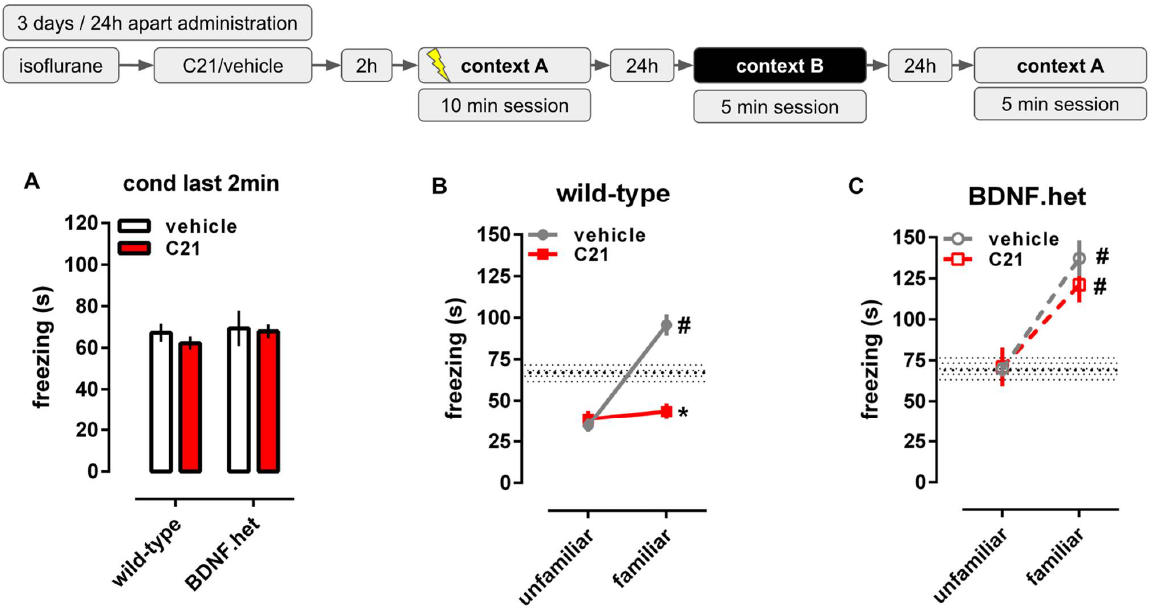
Figure 2. Effects of C21 in wild-type and BDNF haploinsufficient animals (BDNF.het) in contextual fear conditioning. ( A ) Administration of C21 (red bar, 0.3 mg/kg, intranasal) did not affect the freezing reaction at the end (last 2 min) of the conditioning session. ( B ) Treatment with C21 did not affect the freezing reaction in the unfamiliar context but decreased freezing in familiar context on wild-type animals. Hatched area: mean ± SEM of the freezing time of vehicle-treated animals in the last 2 min of the conditioning session. ( C ) Treatment with C21 did not exert any effect in BDNF.het mice. Hatched area: mean ± SEM of the freezing time of vehicle-treated animals of each genotype in the last 2 min of the conditioning session. Data expressed as mean ± SEM of the time spent in freezing (s). * p < 0.05 from the vehicle-treated group at the same trial, # p < 0.05 from the freezing time in the unfamiliar context in the same group ( n =